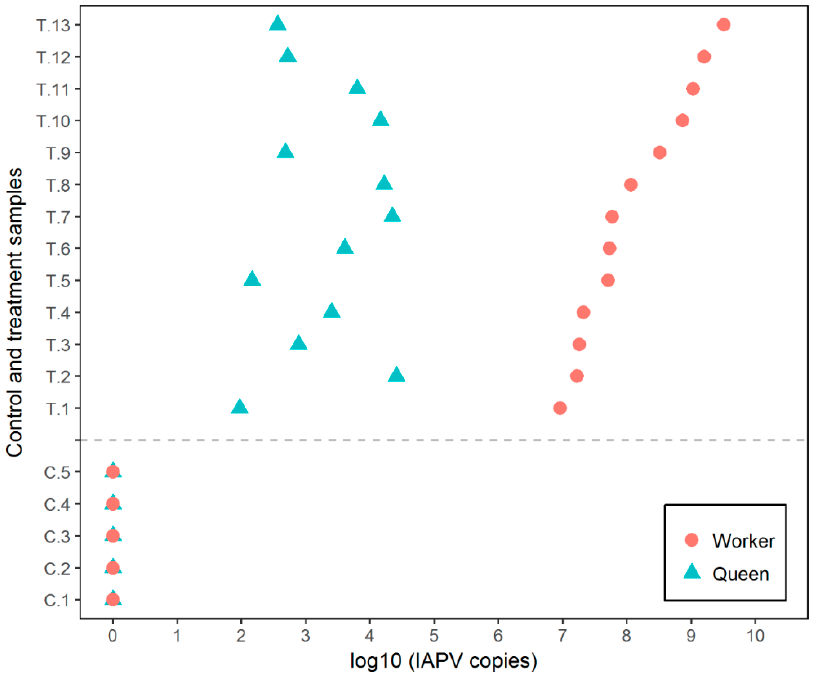
Figure 2. IAPV titers of worker and queen samples in control and treatment groups of trophallactic experiment. IAPV-inoculated workers developed virus to a range from 9.2 × 10 6 to 3.25 × 10 9 copies/µL and consequently, queens in trophallactic contact with infected workers become infected (IAPV range from 9.3 × 10 1 to 2.59 × 10 4 copies/µL), only due to feeding contact with infectious workers. Queens and workers in the control cages remained uninfected. In all cases with detectable IAPV levels, the titers were higher in workers than in the queens. T = IAPV-infected workers, C = control workers.